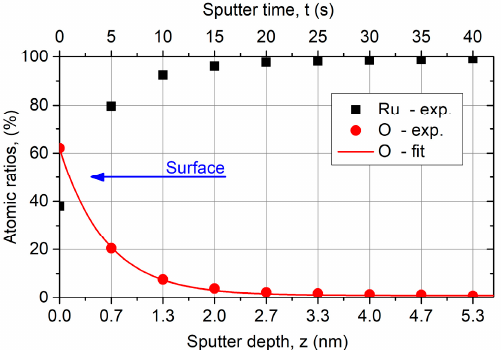
Figure 8. Atomic ratios depth profile for Ru and O of ALD Ru ( z = 57 nm) coating on a Si substrate using Auger electron spectroscopy (AES). The composition on the surface fits RuO 2 , whereby the O content decreases fast with increasing sputter depth and remains at 0.8% in the bulk material. The sputter depth is a rough approximation, whereby the sputter rate is roughly 8 nm/min.